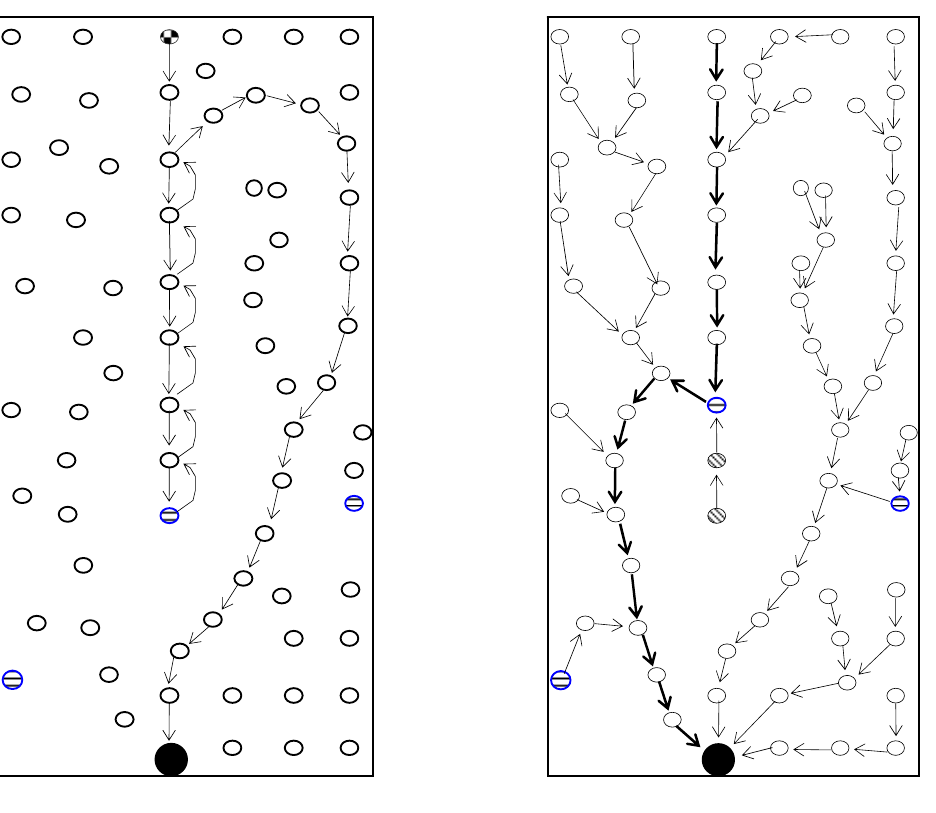
Figure 11. Route by GPSR. Figure 12. Route after implementing